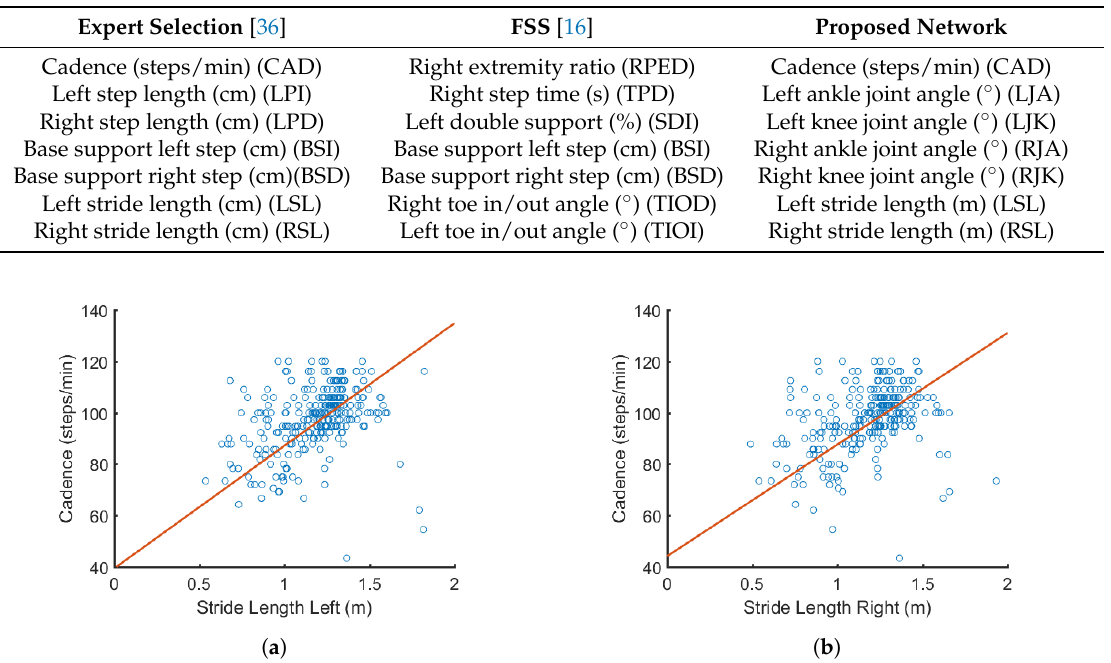
Table 4. Comparing selected features.